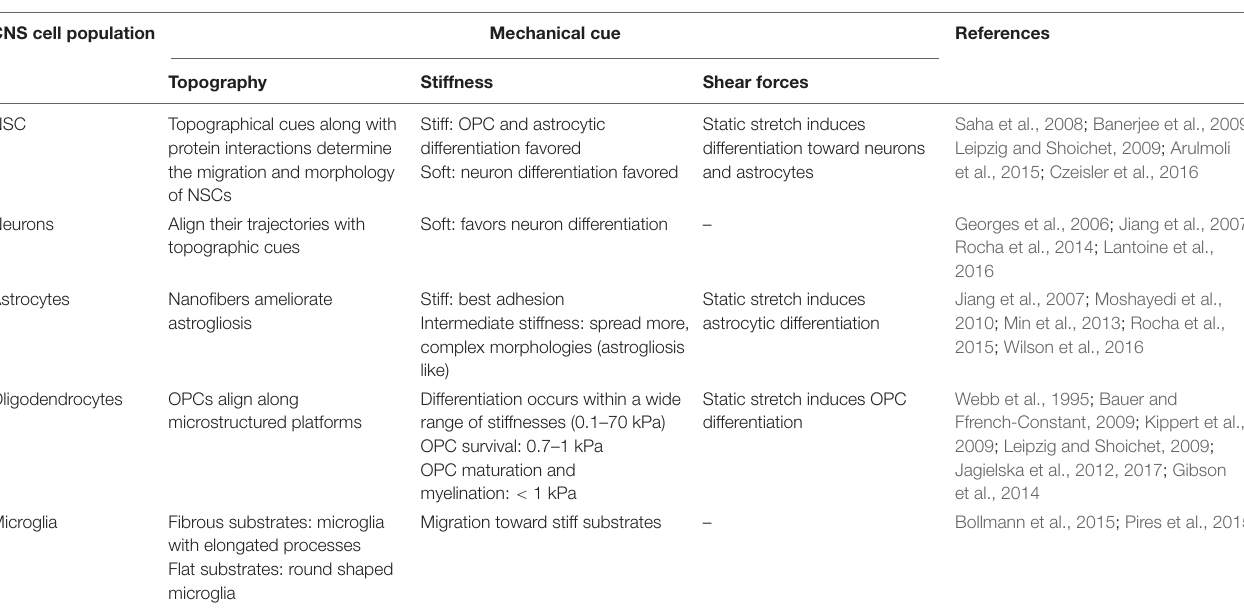
FIGURE 3 | CNS cell differentiation during development as a function of tissue stiffness. Human brain reported stiffness ranges between 0.1 and 1 kPa. Neurons (in green) are generated first at the embryonic stage and differentiate in a softer environment than the remaining cells. Astrocytes (in orange) grow mainly on an environment with intermediate stiffness and finally oligodendrocytes (in blue) can proliferate and differentiate within the wide range of stiffness found in brain tissue. TABLE 2 | The role of the different brain population to mechanical